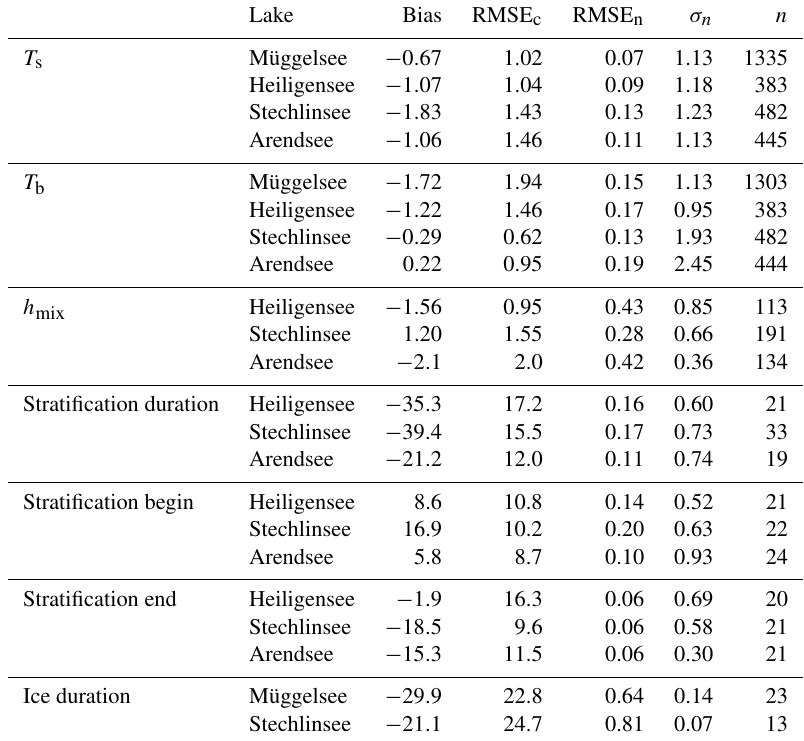
Table 2. Goodness-of-fit statistics of the four study lakes. Stratification statistics not shown for polymictic Müggelsee.